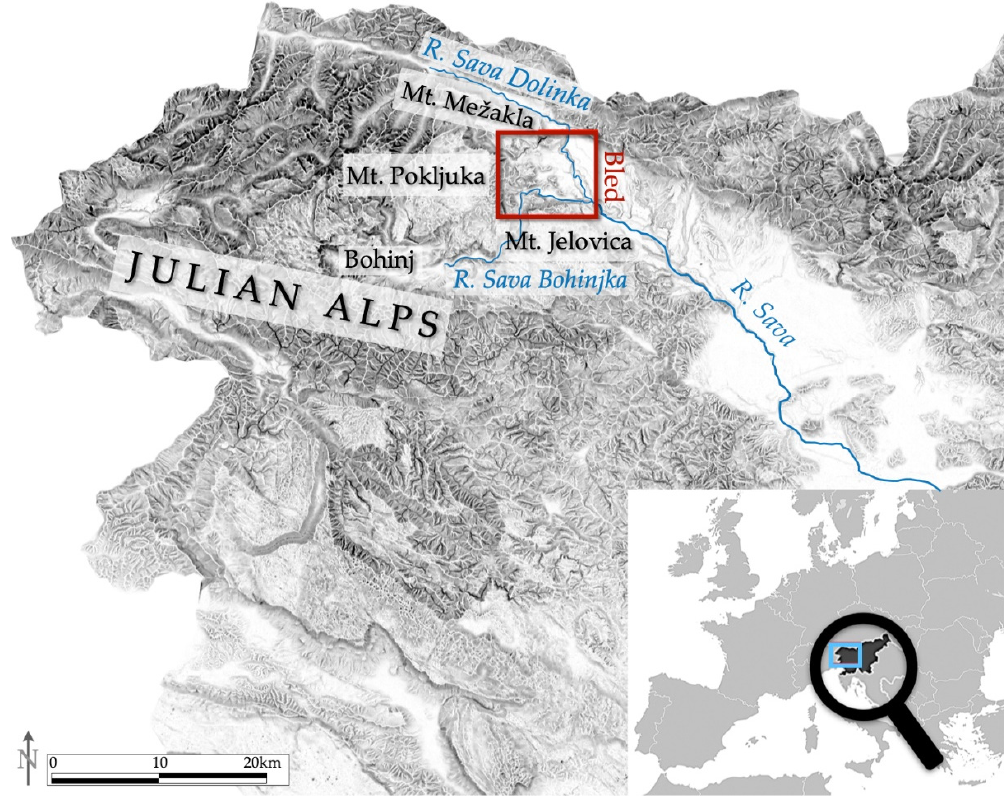
Figure 1. Location of the study area with the most relevant topographic features mentioned in the text (decimal longitude and latitude coordinates of the map centre: 14.1949; 46.1168).